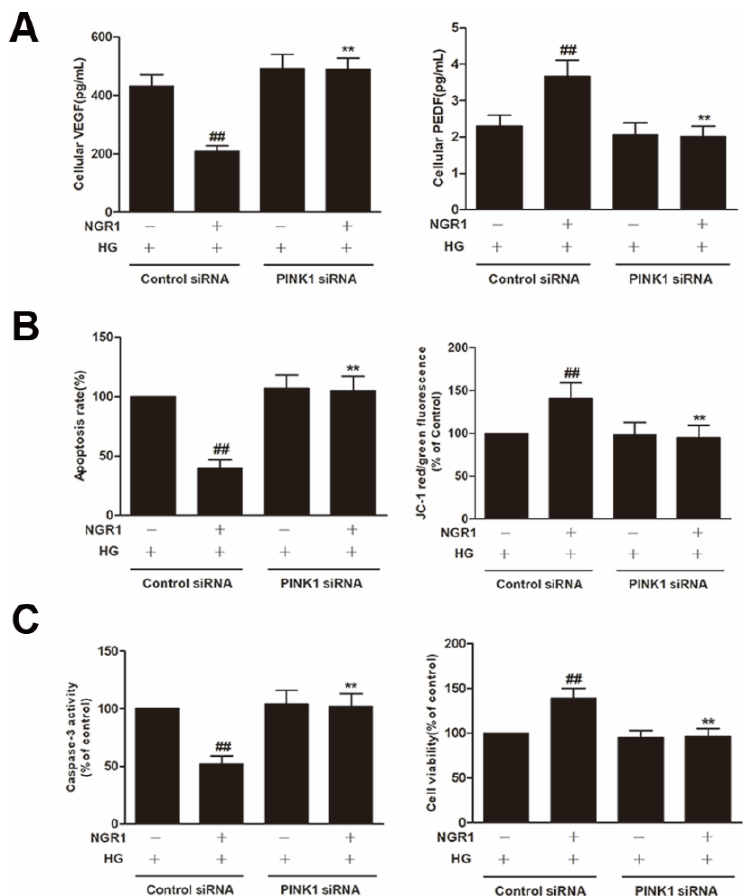
Figure 12. NGR1 attenuated apoptosis via activating PINK1. rMC cells were transiently transfected with PINK1 siRNA. ( A ) The expression of VEGF and PEDF; ( B ) the apoptosis rate and JC-1 ratio; ( C ) the caspase-3 activity and cell viability. The results are expressed as the means ± SD (n = 10). Two groups were analysed by unpaired two-tailed Student’s t tests, and multiple groups were analysed by one-way analysis of variance (ANOVA); ## indicates a significant difference from HG-treated cells transfected with control siRNA ( p < 0.01). ** indicates a significant difference from cells in the NGR1+HG group. (+), treatment with HG or NGR1; ( − ), treatment without HG or NGR1.